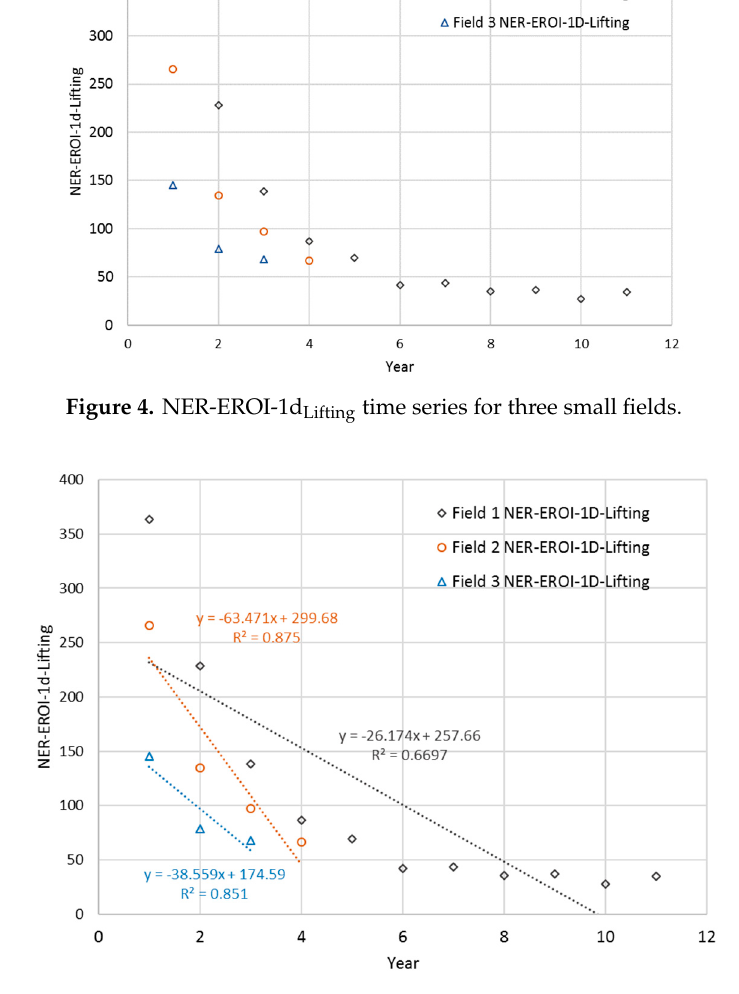
Figure 5. NER-EROI-1d Lifting regression analysis (linear).